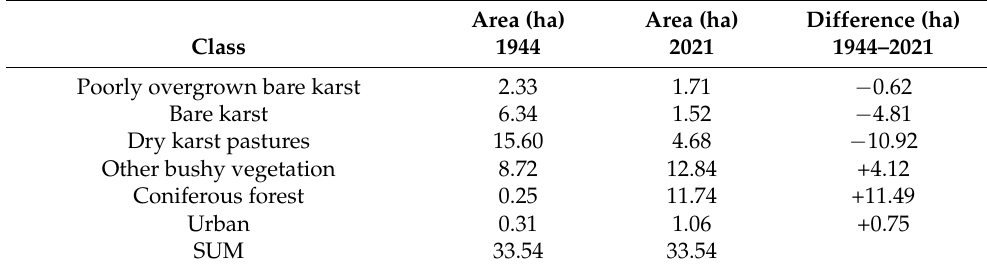
Table 5. LUCCs results for the 1944–2021 time period.